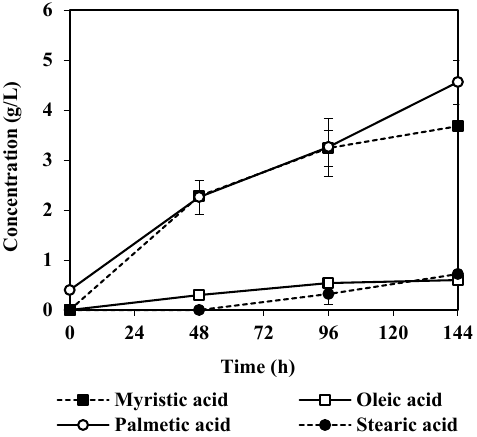
Figure 3. Changes in the concentration of main fatty acids in cream during the cultivation of A. oryzae .